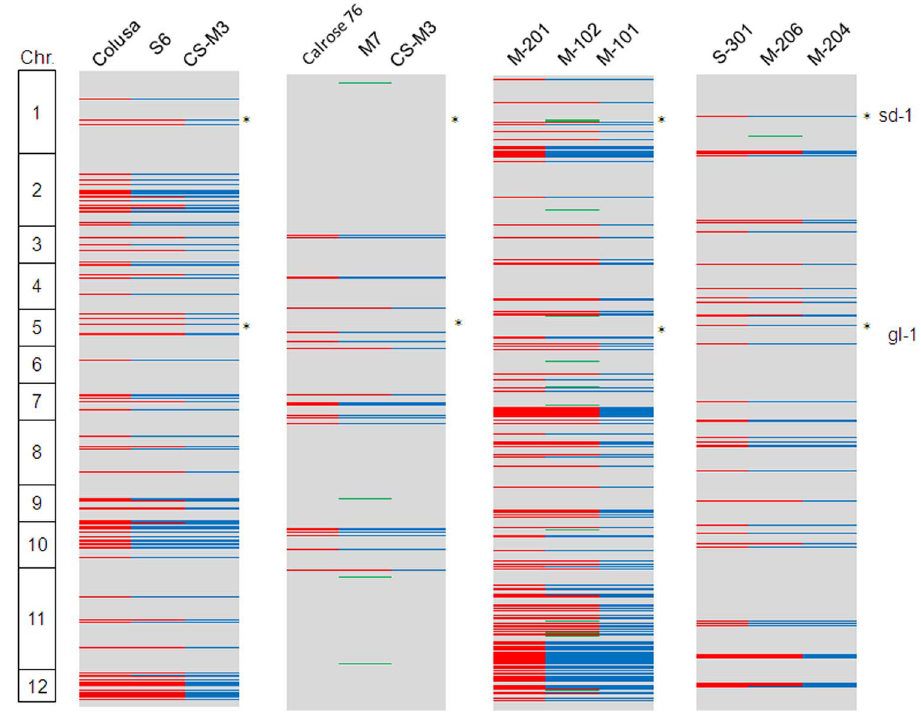
Figure 5. Evaluation of pedigrees of California cultivars derived from bi-parental crosses. Grey areas represent SNPs shared the parents and the descendent cultivars. Red areas represent haplotype blocks shared with the female parent blue areas represent those shared with the male parent. Green areas are haplotypes that are not derived from either parent and may represent scoring errors or differences between the accessions used in this study and those used originally for the breeding of the cultivars. The semidwarf-1( sd-1 ) and glabrous-1 ( gl-1 ) loci are indicated with an asterisk (*).